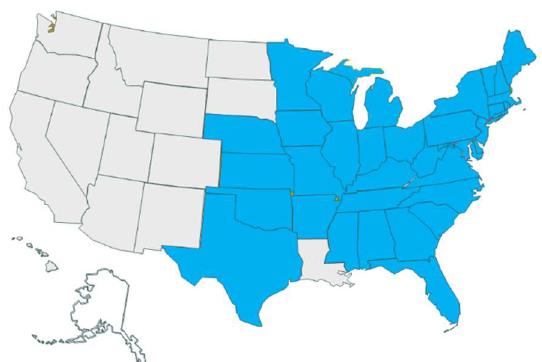
Figure 1. The states (in blue), within the United States of America (USA), from which the data were collected by the United States Department of Agriculture (USDA) Forest Service Forest Inventory Program (FIA) and used in this study. These data are publicly available in the Forest Inventory and Analysis Database (FIADB) [3].